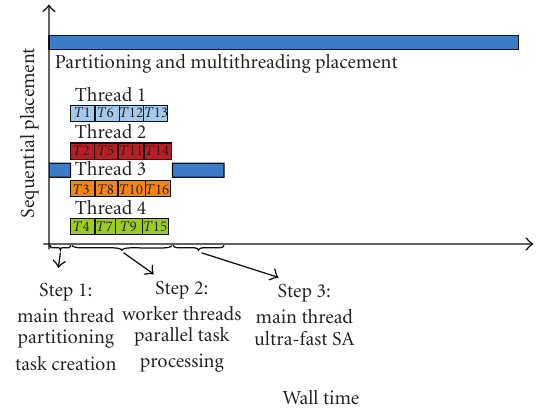
Figure 5: Illustration of Step 2. Sixteen tasks are processed concurrently by four worker threads (see also Figure 3). This step exploits parallelism to achieve overall